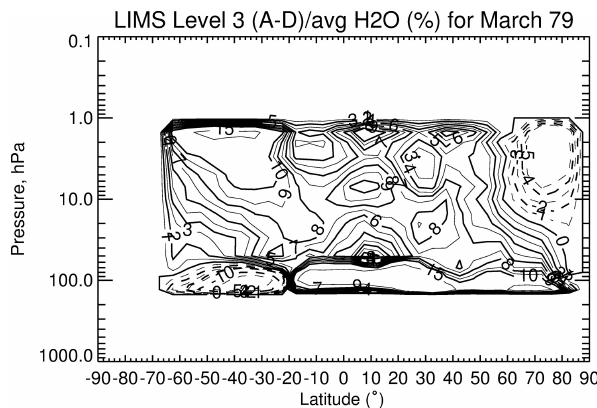
Figure 9. LIMS V6 level 3 ascending minus descending ( A − D ) H 2 O differences divided by average H 2 O (and given in %) for March 1979. CI is 1% from 0 to 10 and then 5% from 10 to 15; solid contours show positive differences.